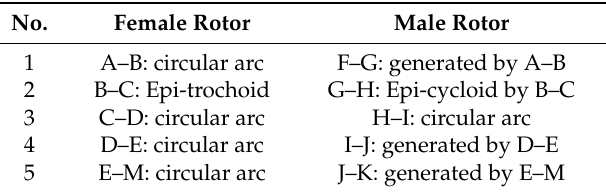
Figure 2. A detailed view of the rotor profile. Table 1. Curve form by point location.